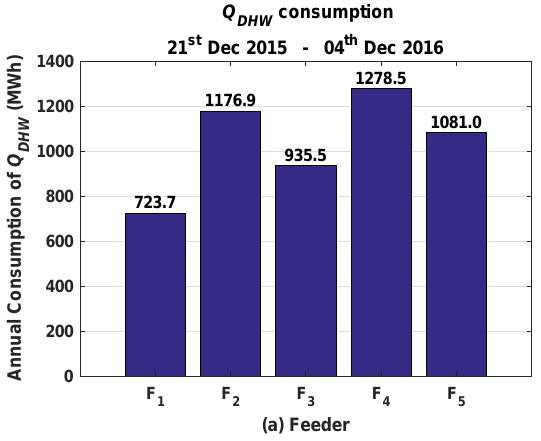
Figure 2. Yearly consumption of Q DHW in different feeders.